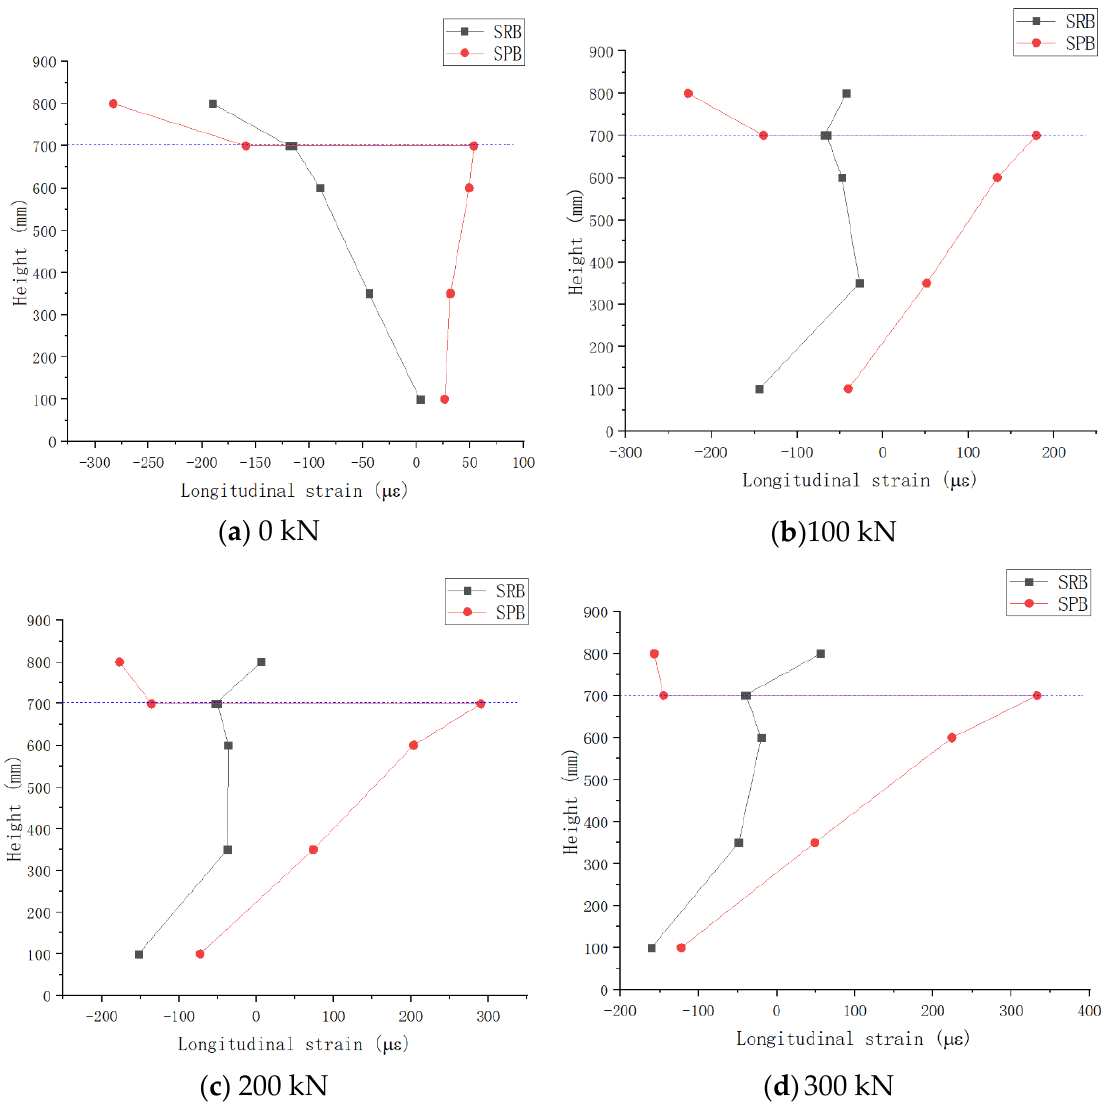
Figure 13. Vertical Distribution of Longitudinal Strain of Steel Box Girder Web.